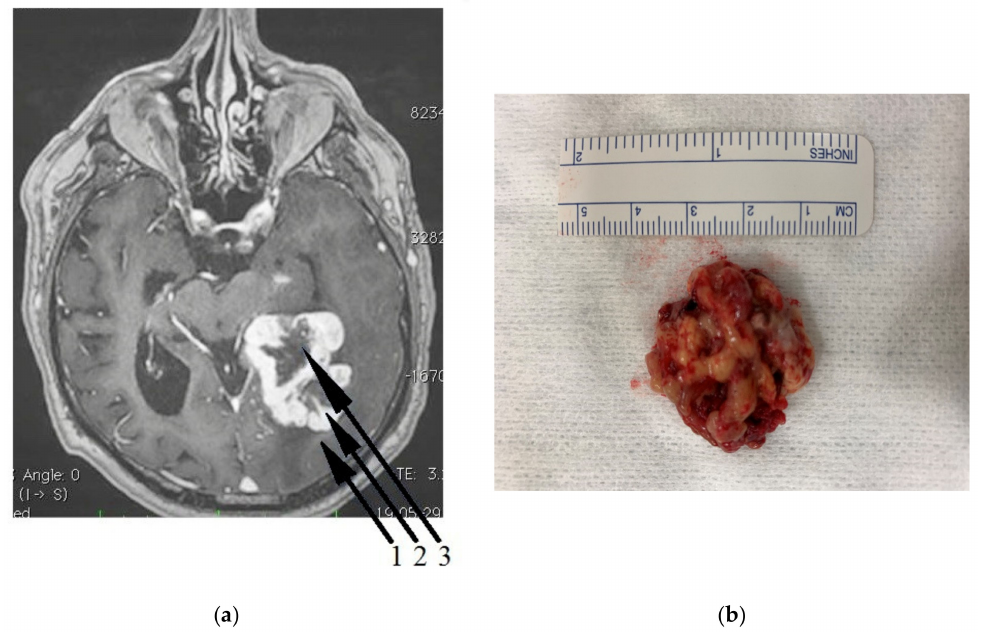
Figure 1. ( a ) Magnetic resonance imaging (MRI) scan of a patient with diagnosed glioblastoma multiforme (GBM). The particular zones 1,2,3 are visible on the tumor cross-section. Zone 1—the peritumoral area, Zone 2—the growing tumor area, Zone 3—the necrotic core. ( b ) GBM tissue obtained from temporal lobe. The tumor was removed by neuronavigation-guided craniotomy. II gyrus cortex was incised over a 5 cm section from the polar end and the central part of the tumor excised, followed by careful and fine debridement with an ultrasonic surgical